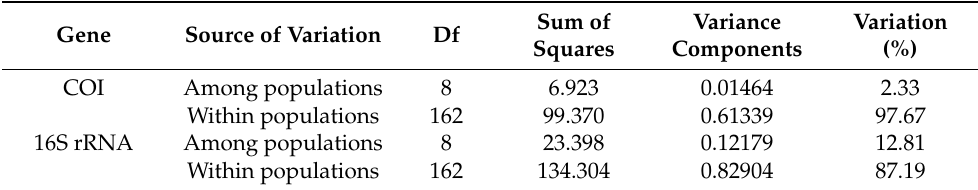
Table 5. Analysis of molecular variance (AMOVA) of COI and 16S rRNA genes in populations of the hilly lineage of